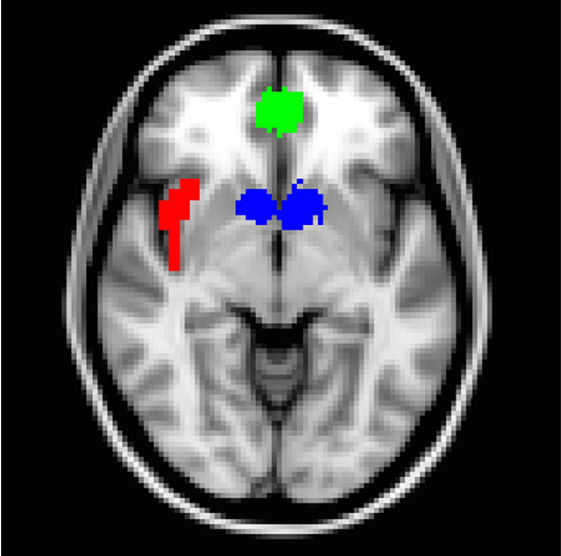
Figure 3. Regions of interest examined within the current study. Ventromedial prefrontal cortex shown in green and striatum shown in blue, from Bartra et al. 26 meta-analysis; right anterior insular cortex (rAIC) shown in red, from Kelly et al. 34 parcellation analysis; MNI x = − 6, y = 10, z = −